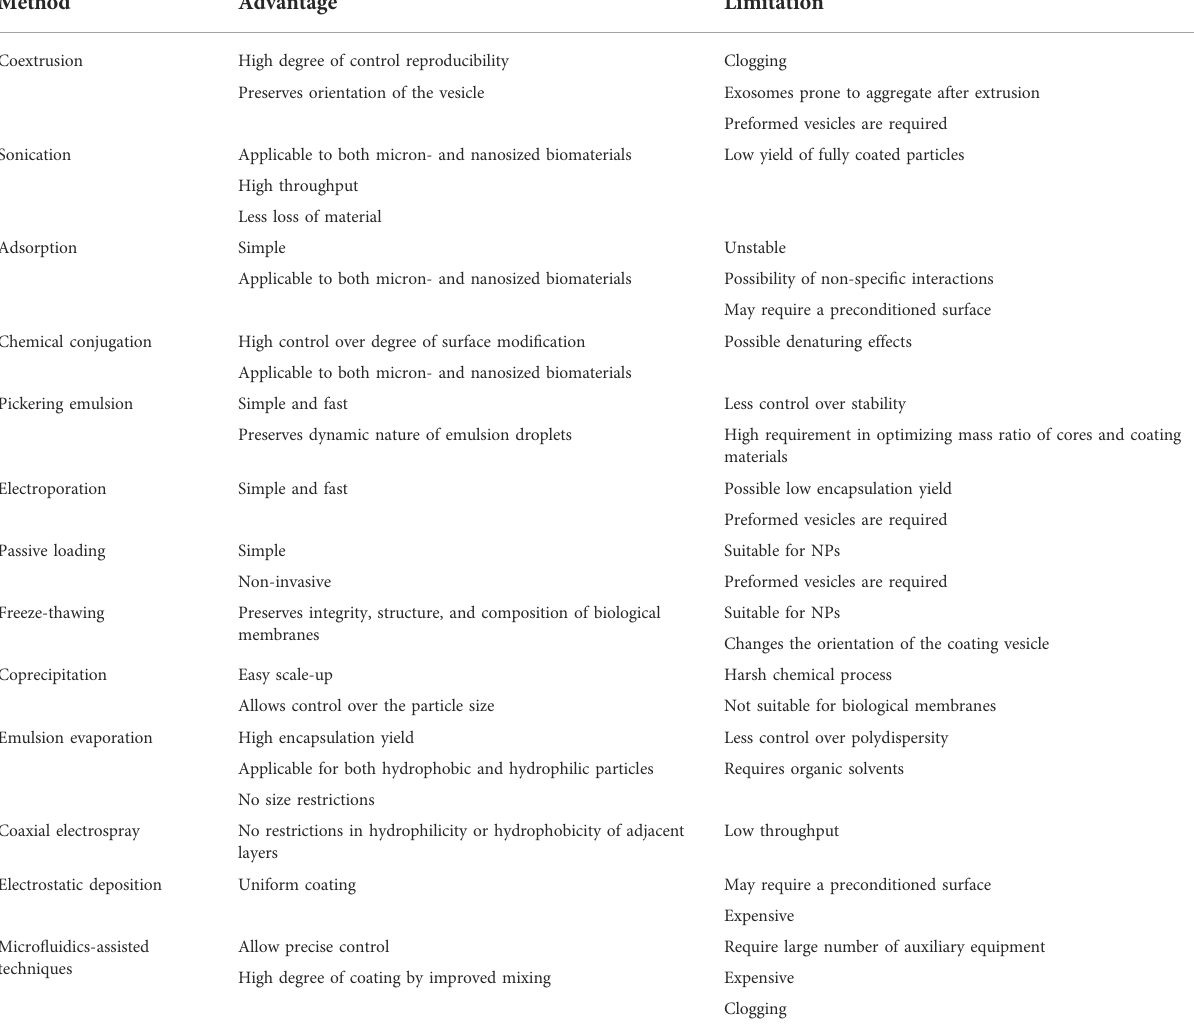
TABLE 8 Advantages and limitations of different surface modi fi cation